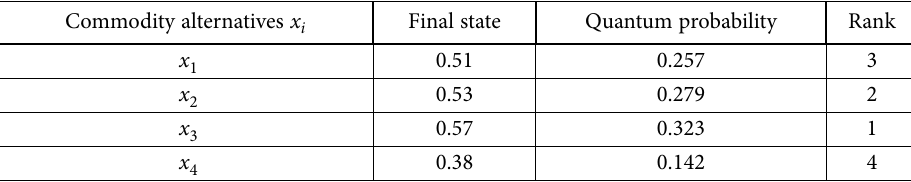
Table 4. Quantum decision